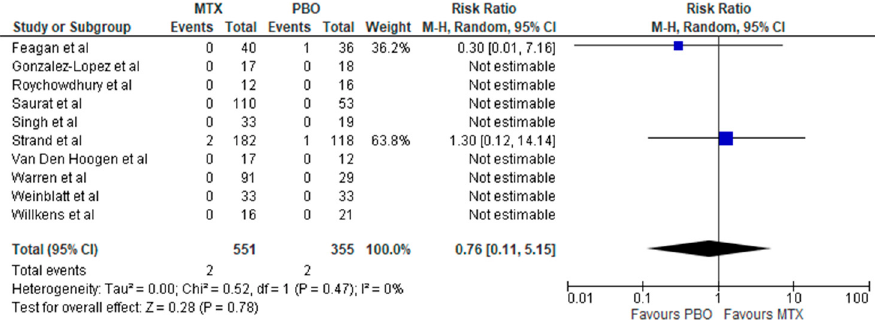
Figure 3. Forest plot: risk of serious infection of MTX vs PBO in inflammatory diseases (Studies included: [28,30,32–39]).